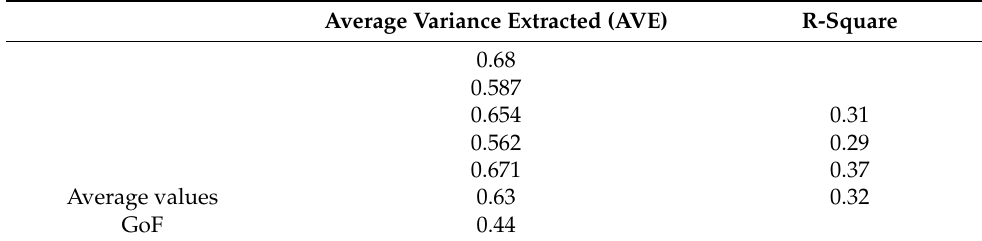
Table 6. The goodness of fit